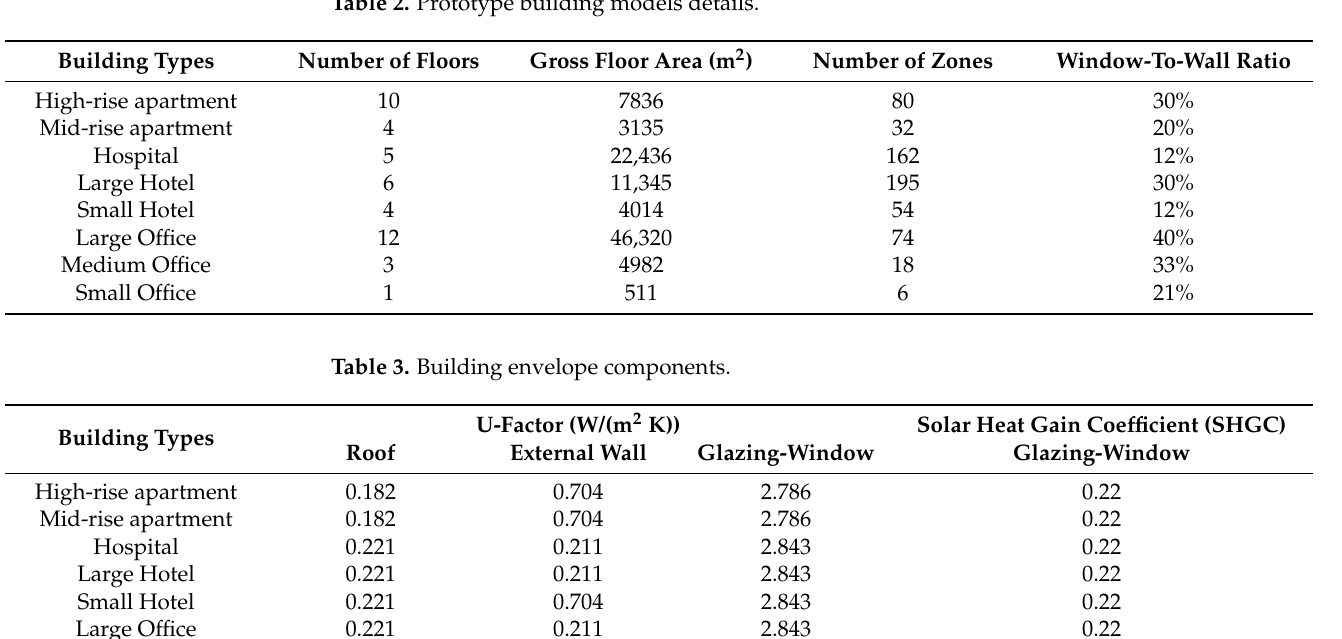
Figure 2. Prototype buildings [64]. Table 2. Prototype building models details.